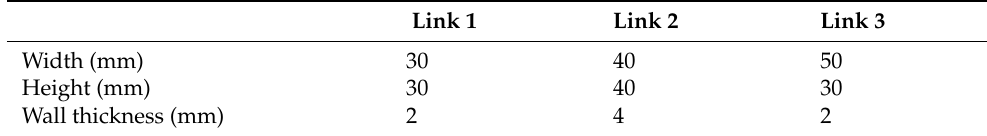
Table 1. Dimensions of the tubes of the links.